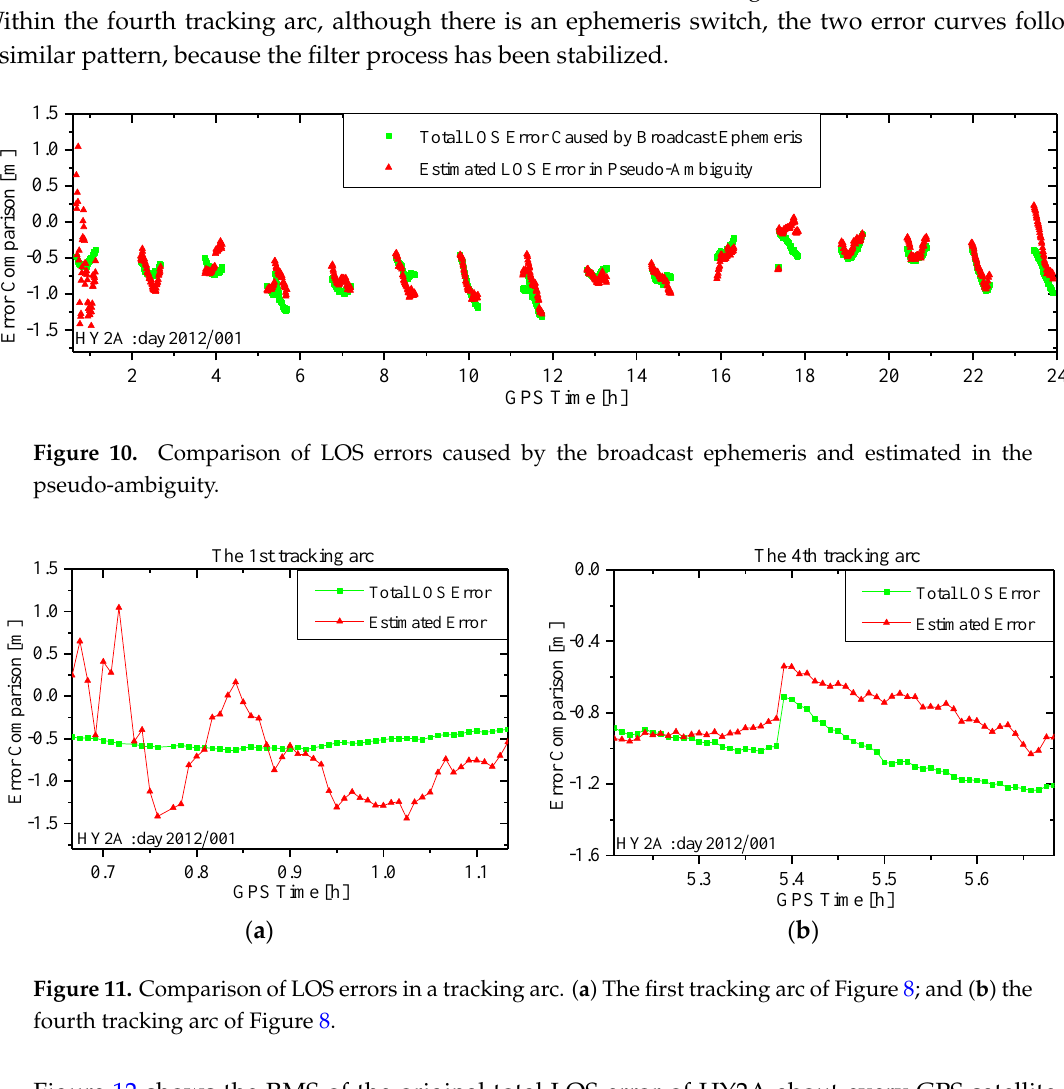
the fourth tracking arc of Figure 8. fourth tracking arc of Figure